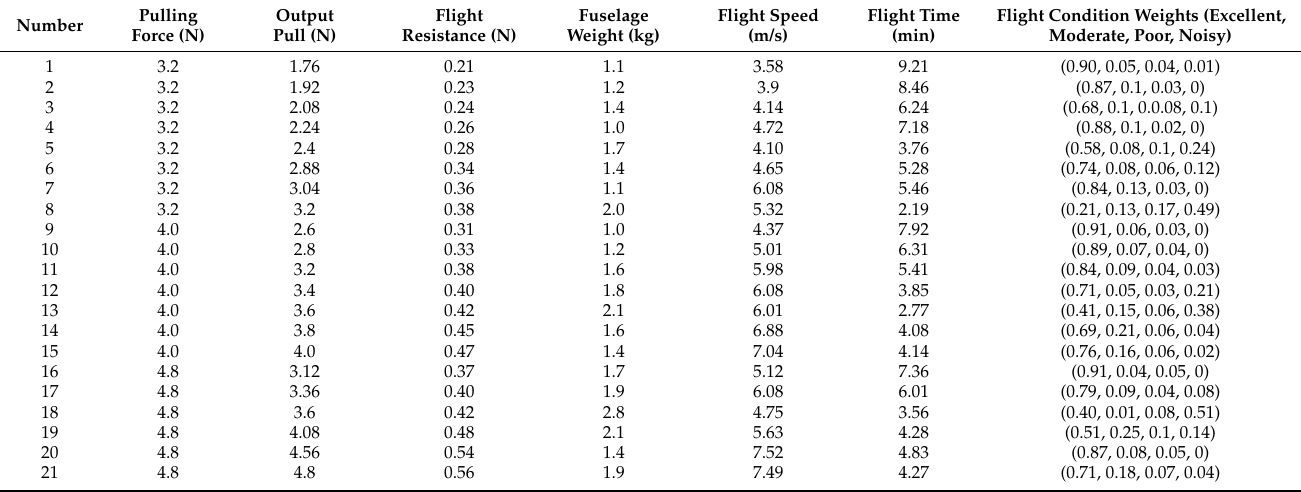
Table 1. Experimental data of logistics UAV.